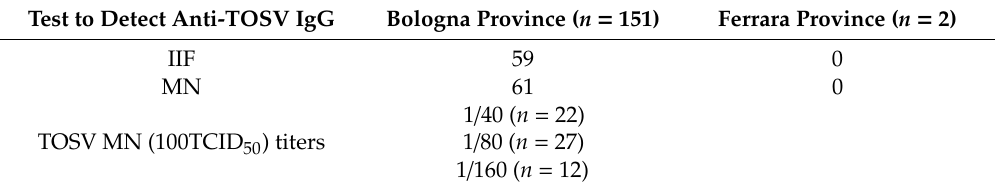
Table 3. Detection of anti-TOSV IgG by indirect immunofluorescence assay (IIF) and microneutralization test (MN) in BDs that previously tested positive or borderline by ELISA-IgG. IIF: indirect